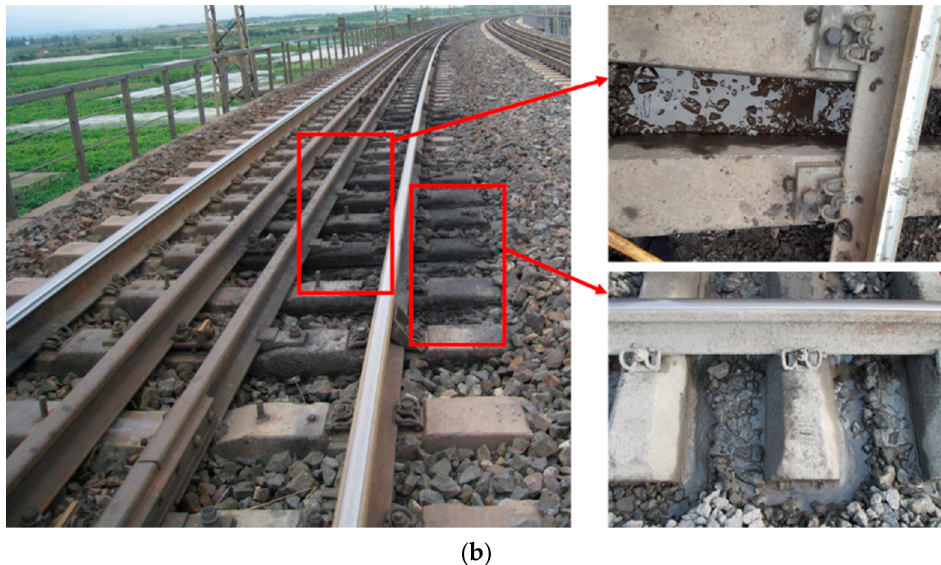
Figure 2. Illustration of the severity of typical ballast bed problems in the railway track section studied: ( a ) coal-dust fouling and ( b ) mud pumps. Table 1. Configuration parameters of typical railcars operated in the D railway.